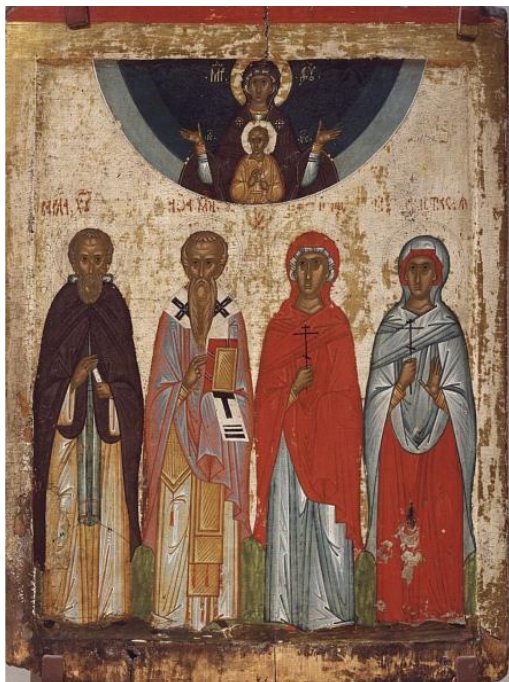
Figure 6. Icon of St. Varlaam of Khutyn, St. John the Merciful, St. Paraskeva, and St. Anastasia with the Virgin of the Sign. Novgorod, 15th century. Russian Museum.